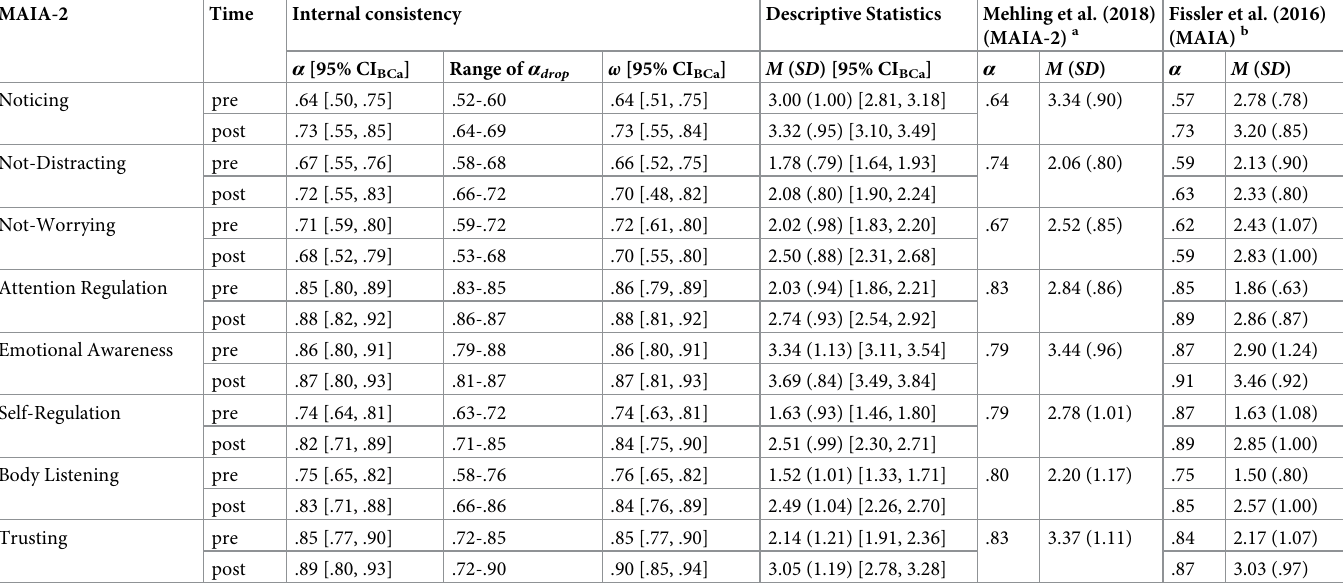
Table 3. Reliabilities and descriptive statistics of the MAIA-2 scales, pre- ( n = 110) and post-treatment ( n = 87). MAIA-2